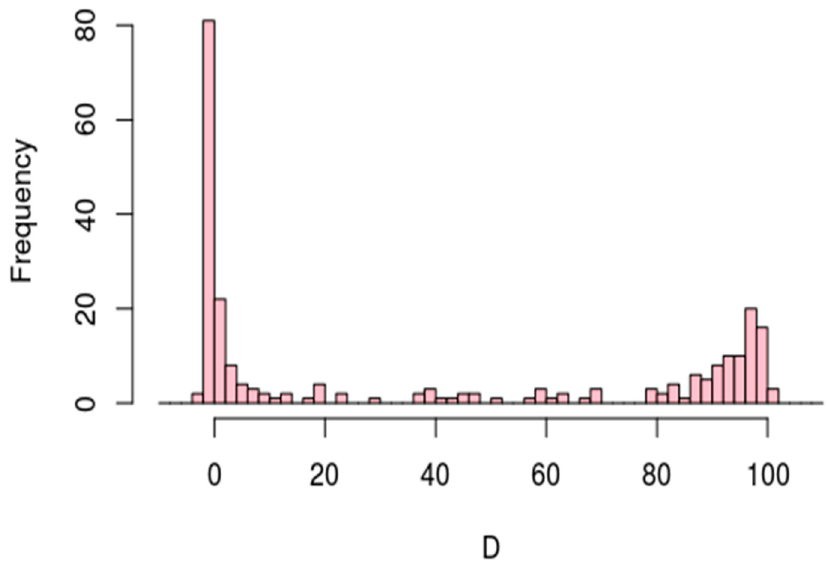
Figure 3. Distribution of CDS length-normalized positions ( D ) of TPS conserved between H. salinarum NRC-1 and H. volcanii DS2. Processing sites at start and stop codons are D = 0 and D = 100, respectively.